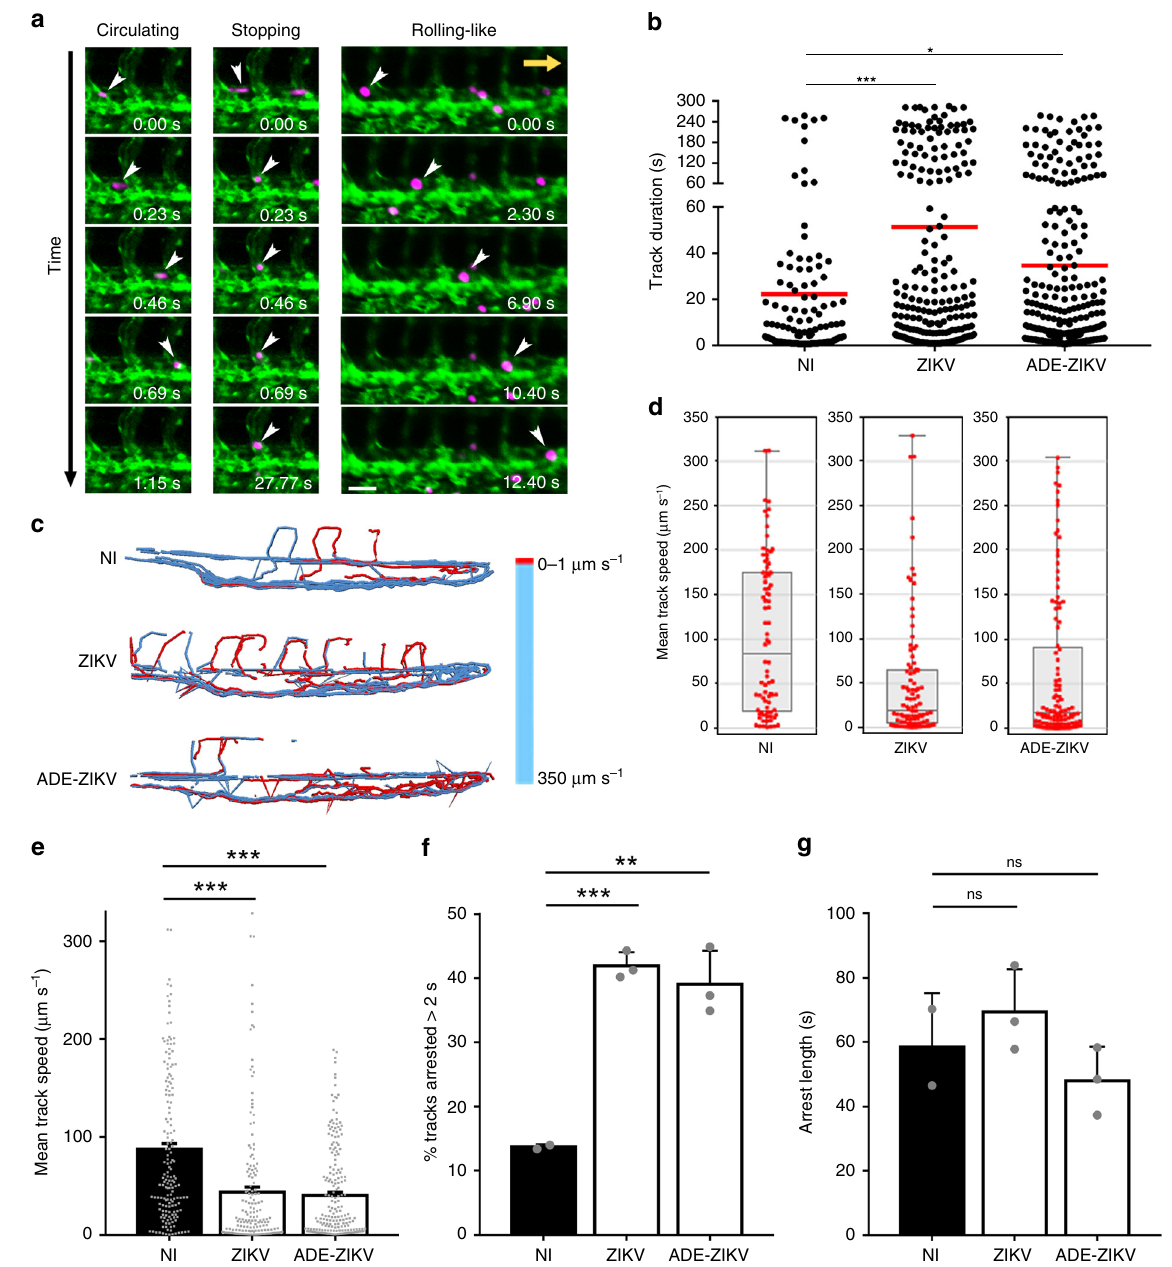
Fig. 8 ZIKV favors monocyte arrest in zebra fi sh vessels, but does not affect their arresting time. Human primary monocytes from three donors were treated and injected as in Fig. 7a, and imaged with an epi fl uorescence microscope immediately after injection (0 – 5 min). a Micrographs representing the type of movement observed (Supplementary Movie S2). White arrowheads indicate examples of monocytes circulating (left panels), stopping (middle panels), or undergoing a rolling-like movement (right panels). Note that timescales are different for each behavior. The yellow arrow represents the direction of the bloodstream. Scale bar: 40 µ m. b – g Monocytes were automatically tracked over time. b The track duration (in seconds) of each monocyte was quanti fi ed. Each dot corresponds to a single monocyte tracked over ≈ 5 min and the red line represents the mean (NI n = 2 fi sh; ZIKV n = 3 fi sh; ADE – ZIKV n = 3 fi sh). c Color-coded representation of monocyte speed in the zebra fi sh vasculature. Red tracks indicate arrested monocytes. d , e Quanti fi cation of the mean track speed of monocytes. Each red dot corresponds to a single monocyte tracked over ≈ 5 min. d The box plots are representative of the data of one fi sh. The center line is the median, the box extends from 25th to 75th percentiles, and the whiskers include from the smallest to the largest value. e The bar graph shows the mean ± SD of NI n = 2 fi sh, ZIKV n = 3 fi sh, and ADE – ZIKV n = 3 fi sh per condition. Each dot is one tracked monocyte. Quanti fi cation of f the percentage and g the arrest length (in seconds) among the monocytes that arrested for more than 2 s. f , g The bar graphs represent the mean ± SEM. Each dot represents the mean of all monocytes tracked in a given fi sh (NI n = 2 fi sh (139 tracks), ZIKV n = 3 fi sh (269 tracks), and ADE – ZIKV n = 3 fi sh (316 tracks)). Two-tailed p value was ns = nonsigni fi cant, <0.05 (*), <0.005 (**), and <0.0001 (***). Statistical signi fi cance was determined by using a t test. Source data in b , e , g are provided as a Source Data fi